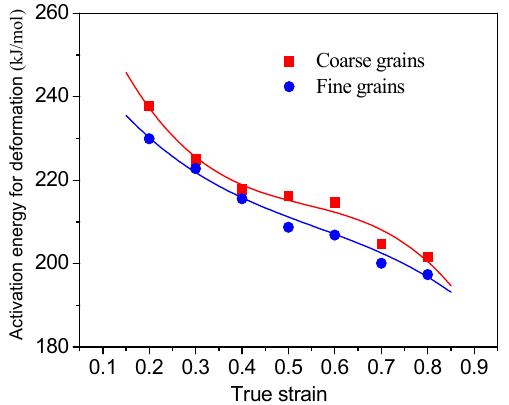
Figure 6. Variation of the activation energy of deformation ( Q ) with true strain for the TB8 titanium alloys with two different initial grain sizes.